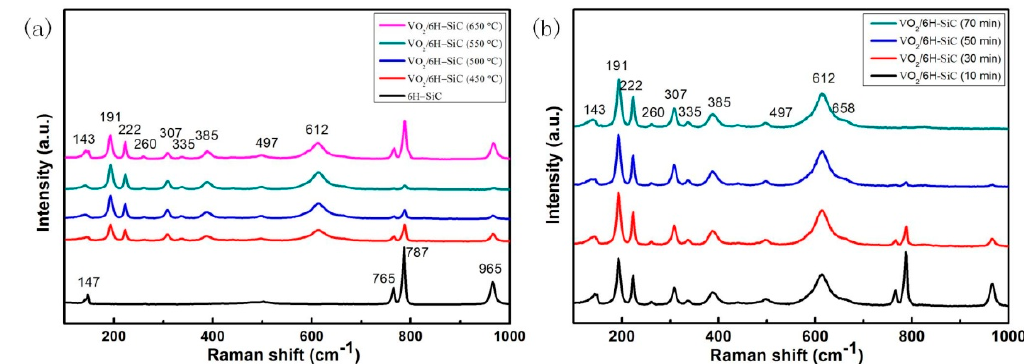
Figure 2. ( a ) Raman spectra of the VO 2 /6H-SiC thin films prepared at different substrate temperatures ( 450 °C, 500 °C, 550 °C , 650 °C ); ( b ) Raman spectra of VO 2 /6H-SiC thin films prepared at different deposition time (10 min, 30 min, 50 min, 70 min) while the substrate temperature remains unchanged at 500 °C .